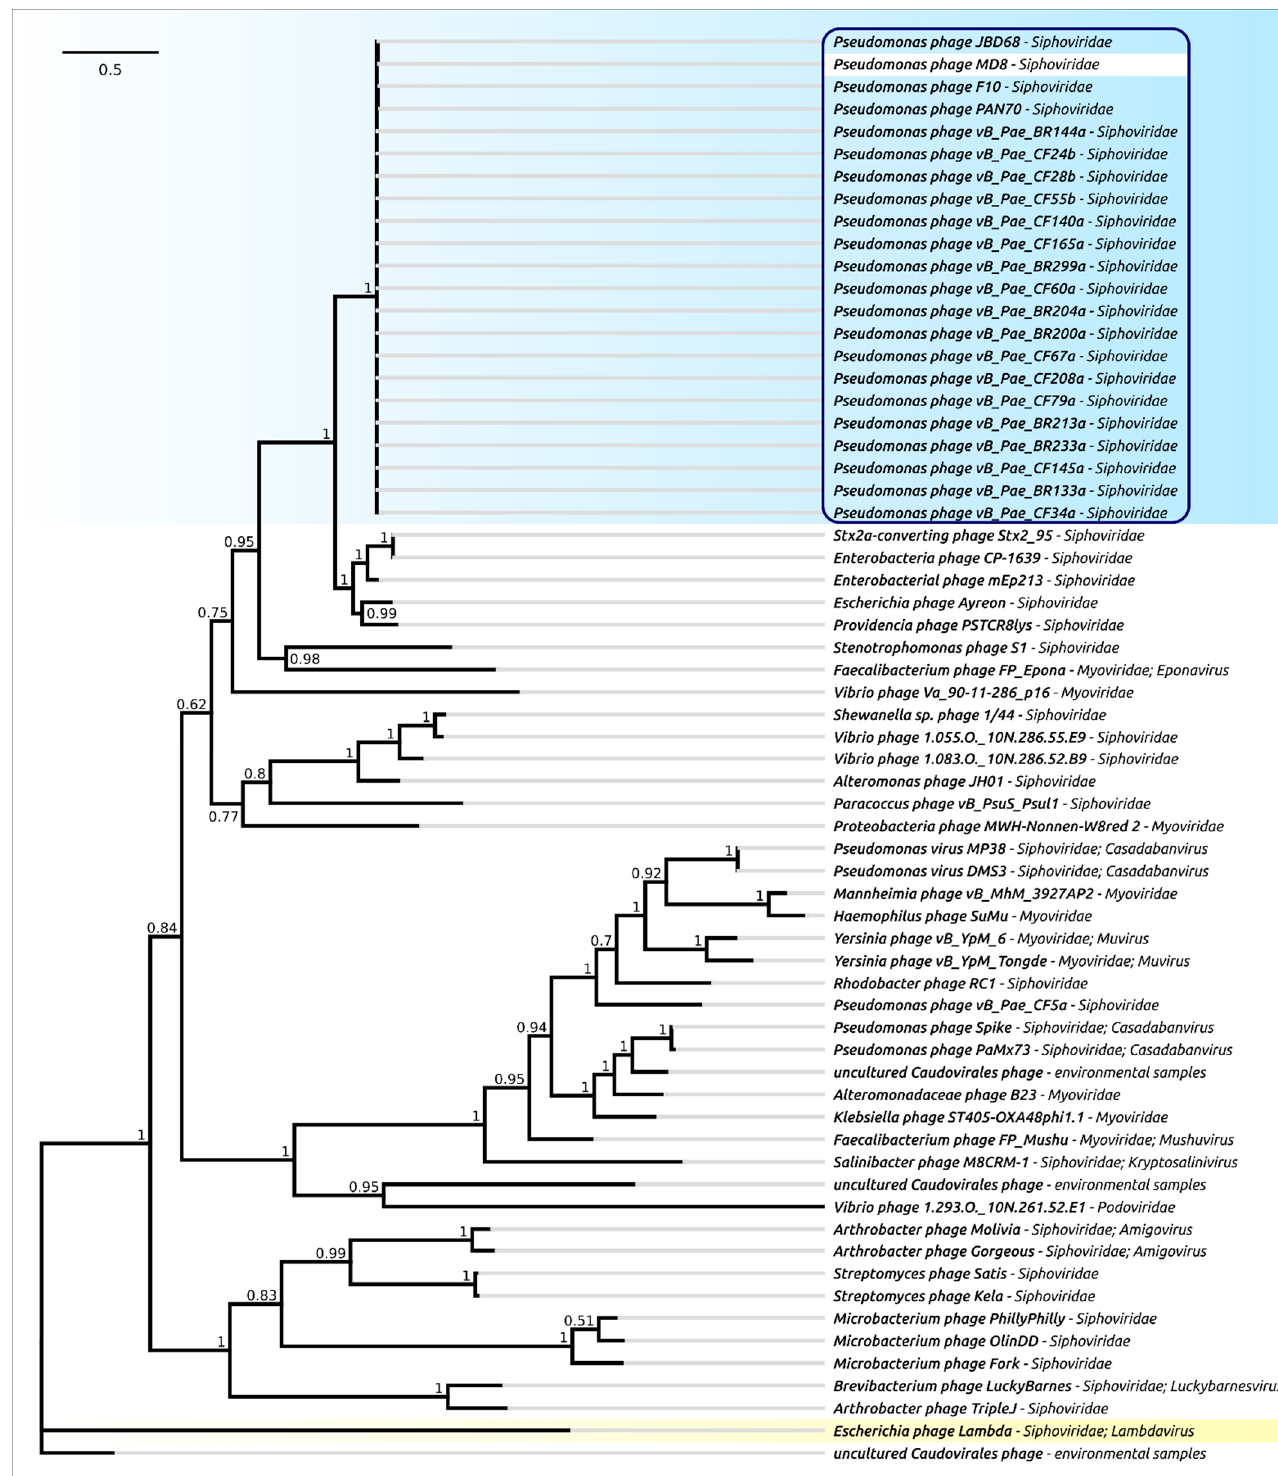
Figure 8. Phylogenetic tree obtained with MRBAYES, based on the major capsid protein domain amino acid sequences. Bayesian posterior probabilities are indicated near their branches. Taxonomic classification is shown to the right of the phage’s name. The scale bar shows 0.2 estimated substitutions per site and the tree was rooted to phage λ . The chain length was 2,200,000, the burn-in length was 200,000, the subsampling frequency was 200 and the average standard deviation of split frequencies was 0.007.